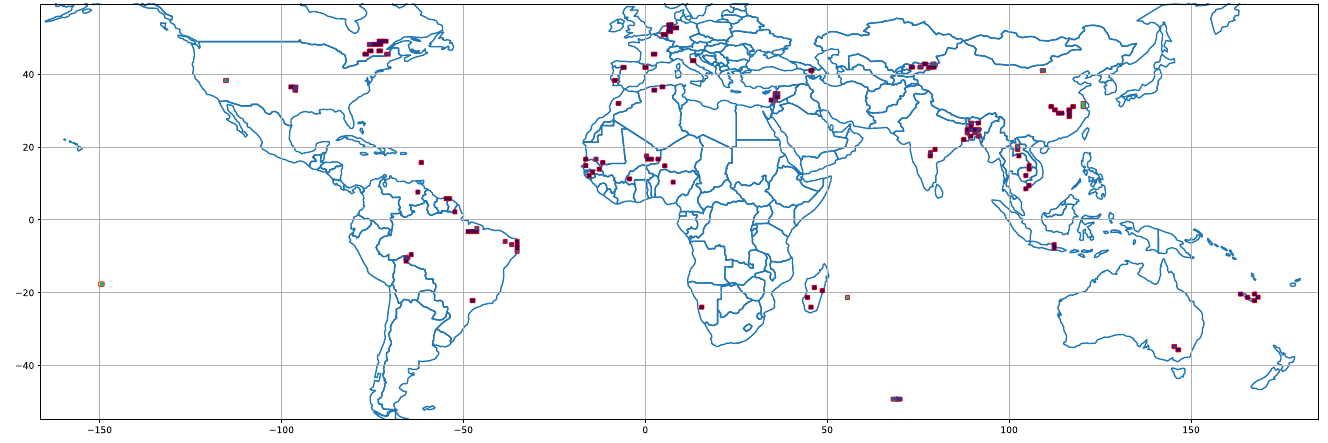
Figure 2. Geographic distribution of the tiles used for the